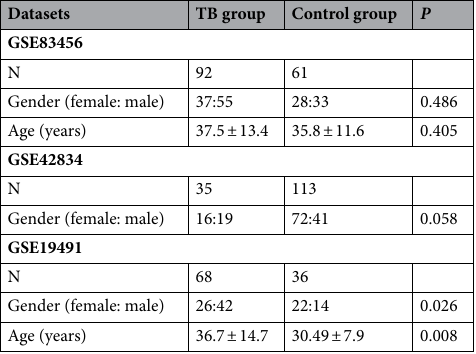
Table 1. The general characteristics of participants in the three datasets. Abbreviations: TB, tuberculosis; N, number.